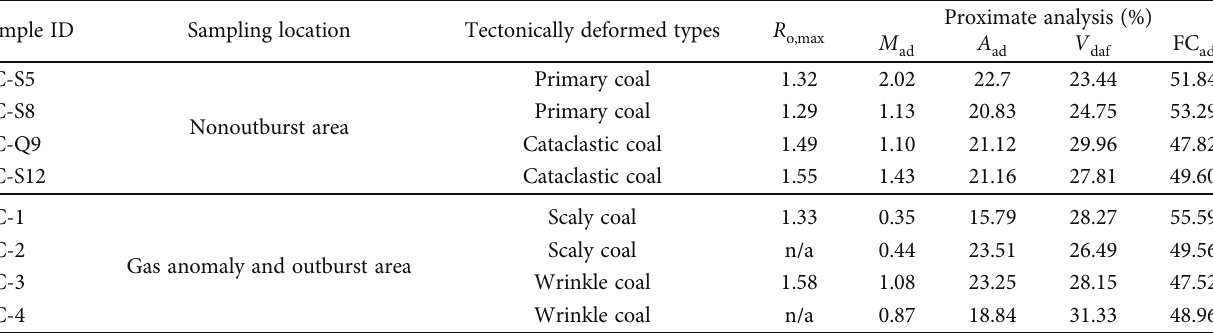
Table 1: Basic information and testing data of the coal